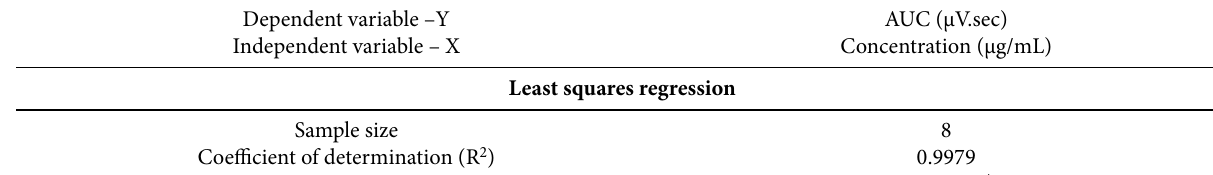
Table 2. Regression analysis of the data Dependent variable –Y AUC (µV.sec) Independent variable – X